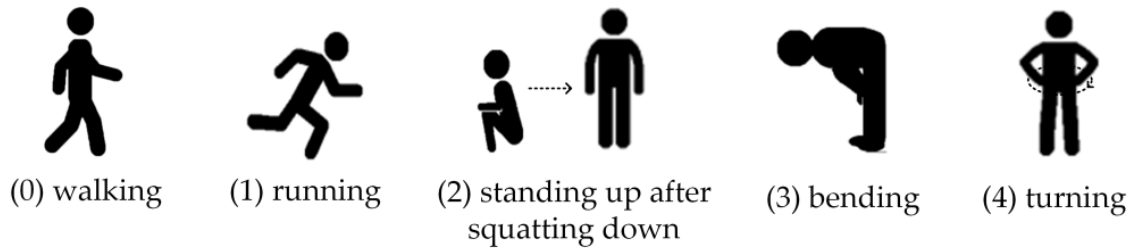
Figure 11. The sketch maps of the five human activities.